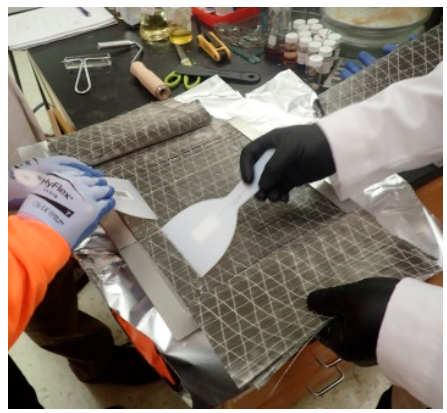
Figure 3. Saturating fibers in epoxy vinyl ester during composite preparation.